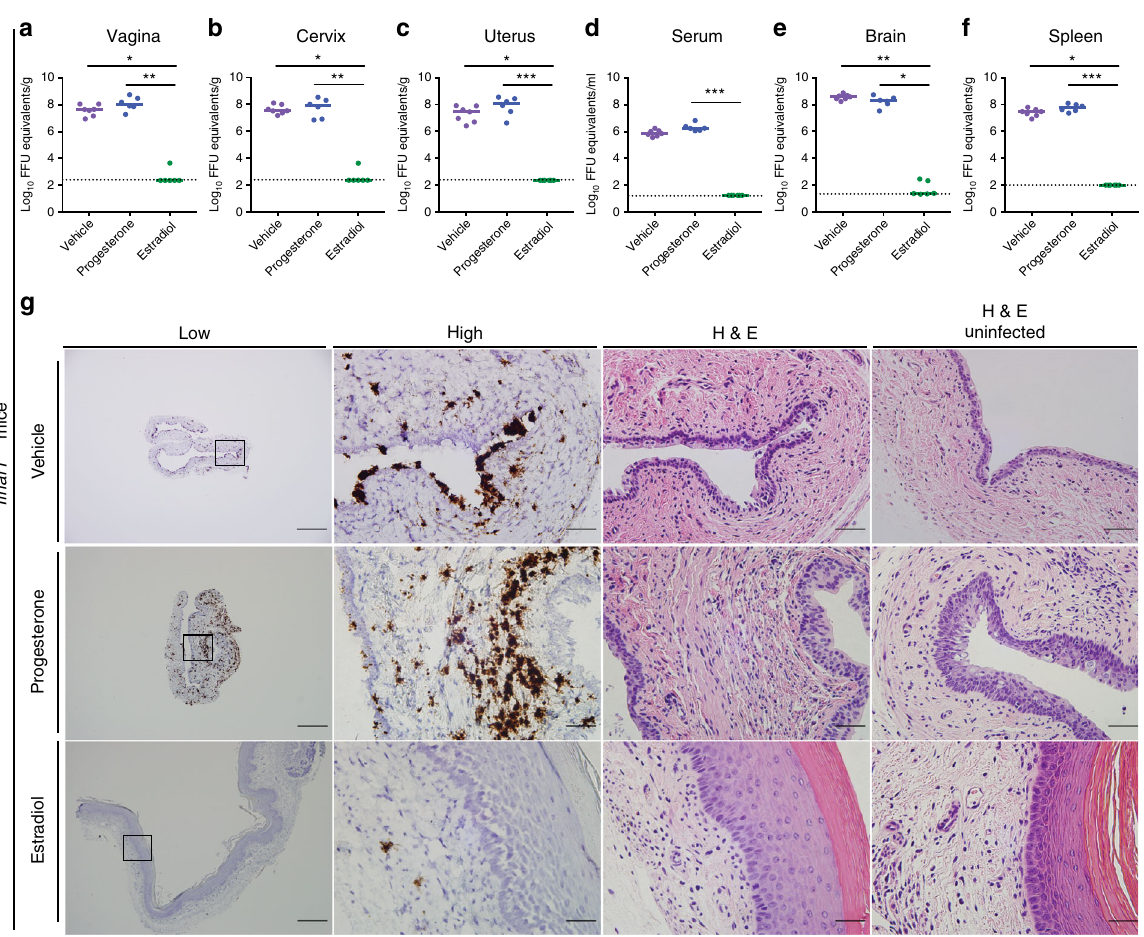
Fig. 2 Estradiol protects Ifnar1 − / − mice from intravaginal ZIKV infection. Six-week-old Ifnar1 − / − OVX mice were given a hormone replacement regimen of estradiol, progesterone, or vehicle. Subsequently, mice were inoculated via intravaginal route with 10 6 FFU of ZIKV (Dakar 41525). At 6 dpi, ZIKV RNA was measured from the vagina ( a ), cervix ( b ), uterus ( c ), serum ( d ), brain ( e ), and spleen ( f ). Dotted lines indicate the limit of detection (LOD) for each assay. Results are pooled from two or three experiments. Bars indicate median values (Kruskal – Wallis test: *, P < 0.05 **, P < 0.01 ***, P < 0.001). Vaginal tissue was stained using H&E or by ISH for ZIKV RNA ( g ). Low magni fi cation scale bar = 500 μ m, high magni fi cation scale bar = 50 μ m. Numbers of mice: vehicle n = 7, progesterone n = 6, estradiol n = 6. Representative images are